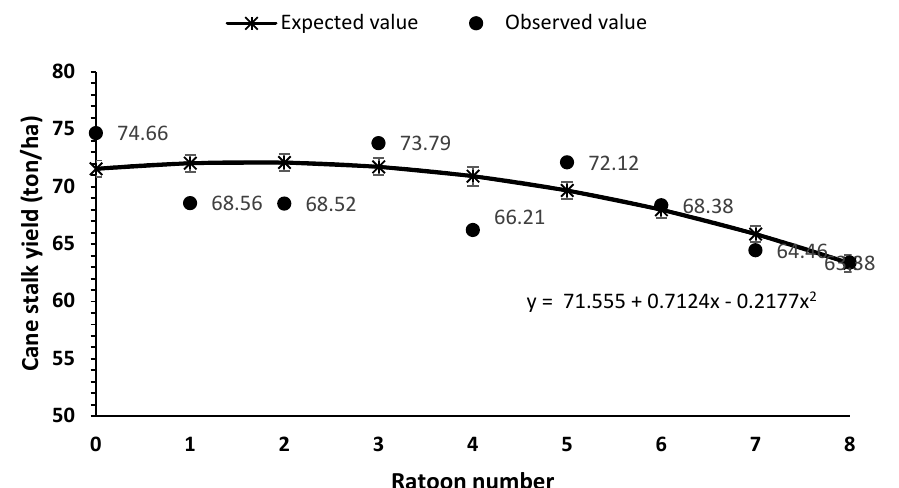
Figure 3. Effect of the number of ratoon crops on cane stalk yield.